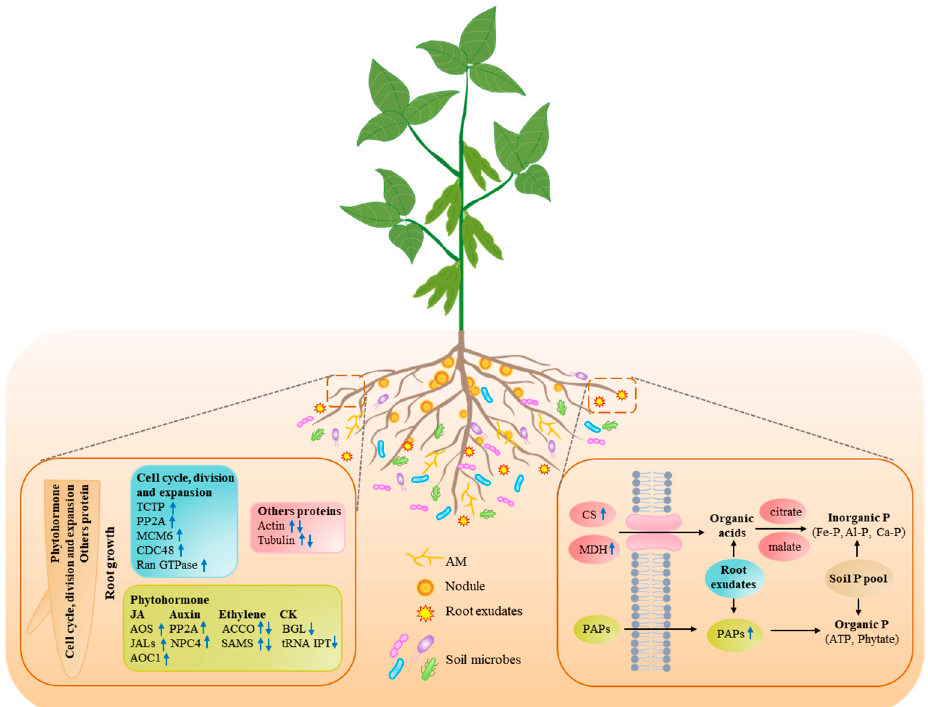
Figure 2. A model of integration of adaptive strategies of plant roots to Pi starvation regulated by DAPs. Up or down arrows indicate DAPs exhibiting increased or decreased accumulations; AM, arbuscular mycorrhiza; ACCO, 1-aminocyclopropane-1-carboxylate oxidase; AOC1, allene oxide cyclase 1; AOS, the allene oxide synthase; BGL, beta-glucosidase; CDC48, cell division cycle protein 48; CS, citrate synthase; JALs, jacalin-related lections; MCM6, mini-chromosome maintenance protein 6; MDH, malate dehydrogenase; PAPs, purple acid phosphatases; PP2A, phosphatase 2A; NPC4, non- phospholipase C4; Ran GTPase, GTP-binding nuclear protein RAN-B1; SAMS, S-adenosyl methionine synthase; TCTP, translationally controlled tumor protein; tRNA IPT, tRNA isopentenyl